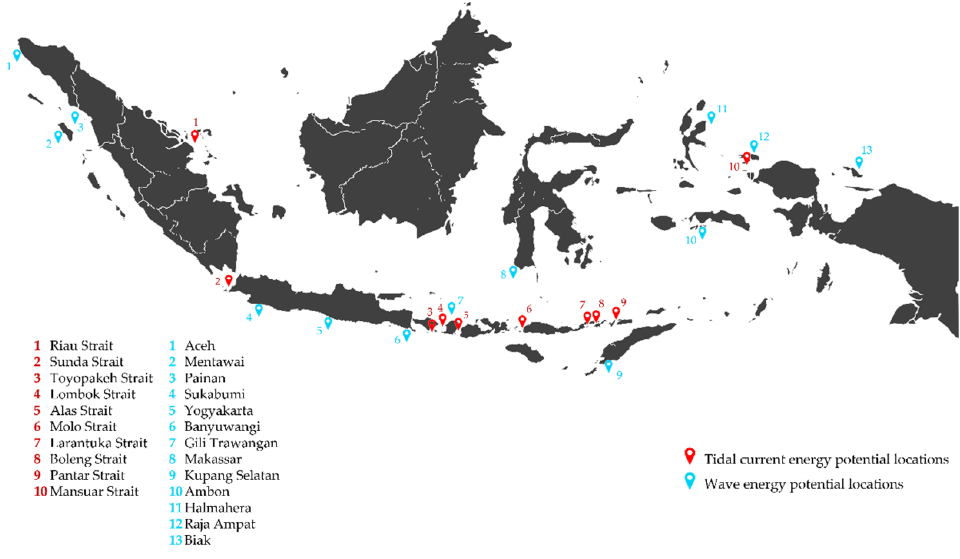
Figure 2. A map of locations of MRE resources in Indonesia (adapted from [7,8,10,11]).